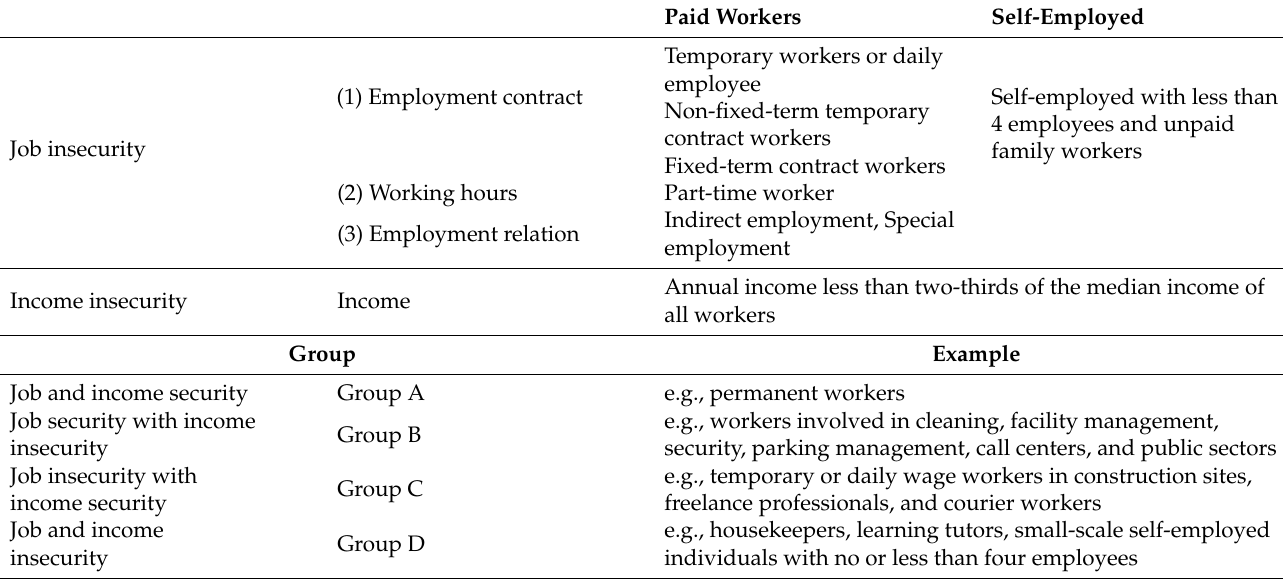
Table 1. Definition of research